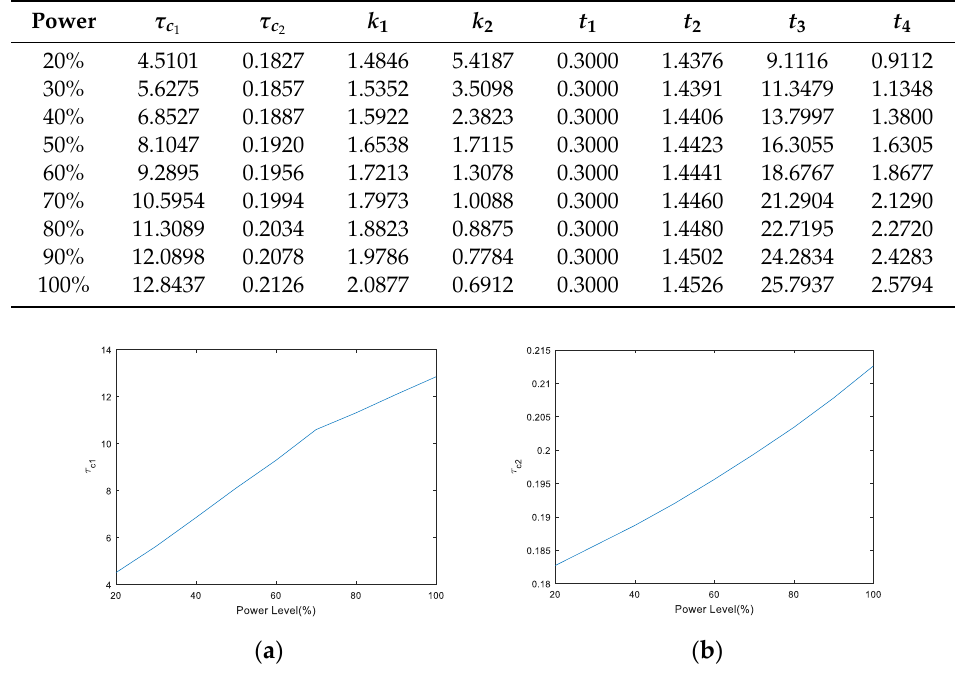
 Figure 13. τ c and τ c at di ff erent power levels. ( a ) refers to parameter τ c  at different power levels. ( a ) refers to parameter Figure 13. and 1 2 1 c 2 c  . parameter 2 c